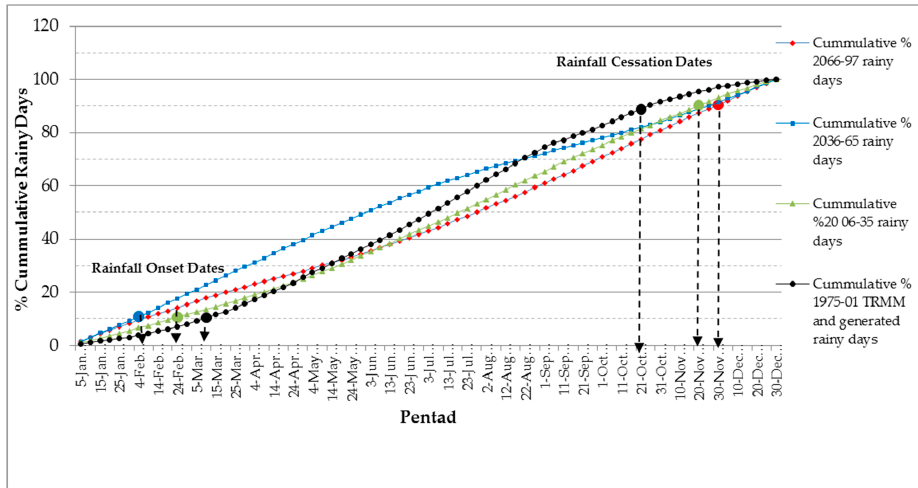
Figure 6. Agago Future Mean Rainfall Onset and Cessation (TRMM Rainfall (1975–2005) and projected (CanESM2) 2006–2035, 2036–2065 and 2066–2099).